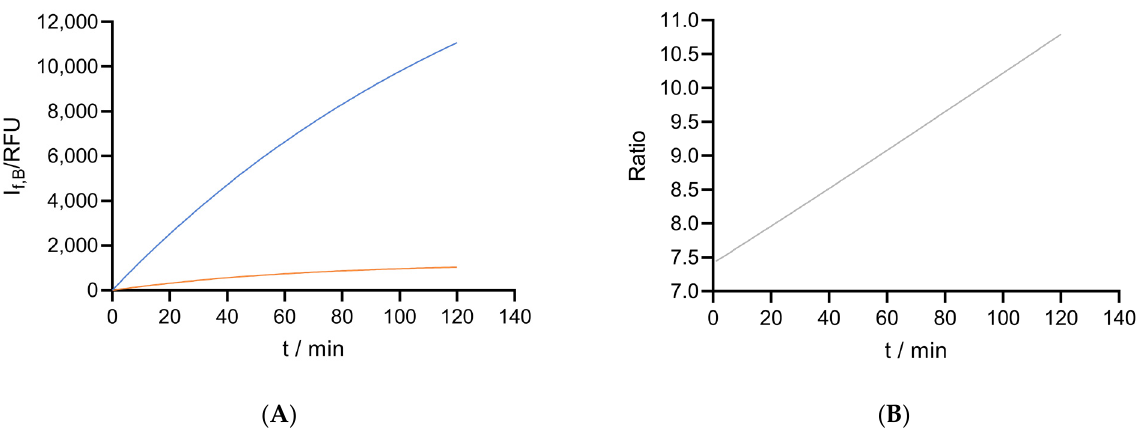
Figure 2 . Fitting curves of the data presented by Lavogina et al . [8] on the metabolic activity of HeLa Figure 2. Fitting curves of the data presented by Lavogina et al. [8] on the metabolic activity of HeLa cells in the absence (blue) and presence of 10 µM doxorubicin (orange) (panel A ) and ratio of the cells in the absence (blue) and presence of 10 µ M doxorubicin (orange) (panel A ) and ratio of the two two fitted curves (panel B ). For the fitted curves in (panel A ), 𝑘 (cid:2870) /𝑘 (cid:2869) was 14.4 and 0.00 for the sample fitted curves (panel B ). For the fitted curves in (panel A ), k 2 / k 1 was 14.4 and 0.00 for the sample with with and without doxorubicin, respectively. [A]( t = 0) was set equal in both conditions. and without doxorubicin, respectively. [A]( t = 0) was set equal in both